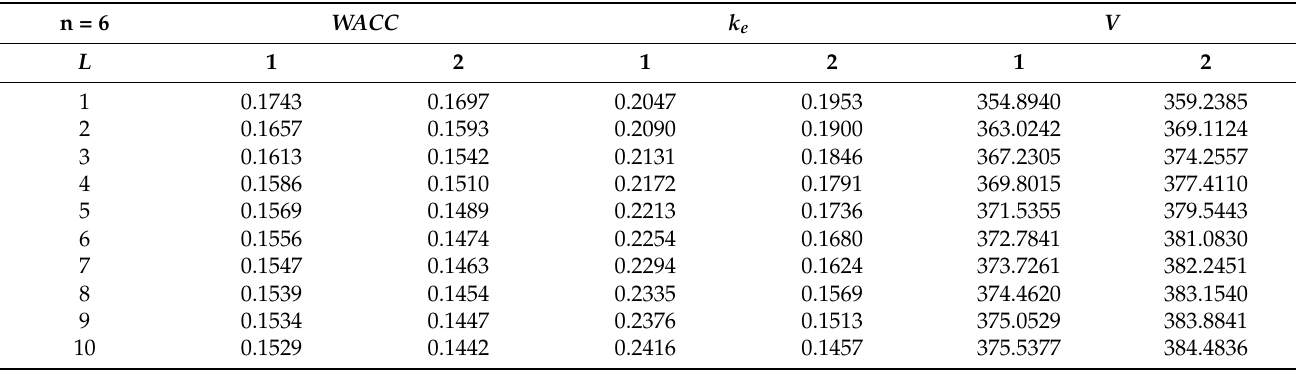
Table 2. Dependence of the weighted average cost of capital, WACC , equity cost, k e and company value, V , on leverage level L in the cases of payments of tax on profit at the end of the year (1) and in the beginning of the year (2) for six-year